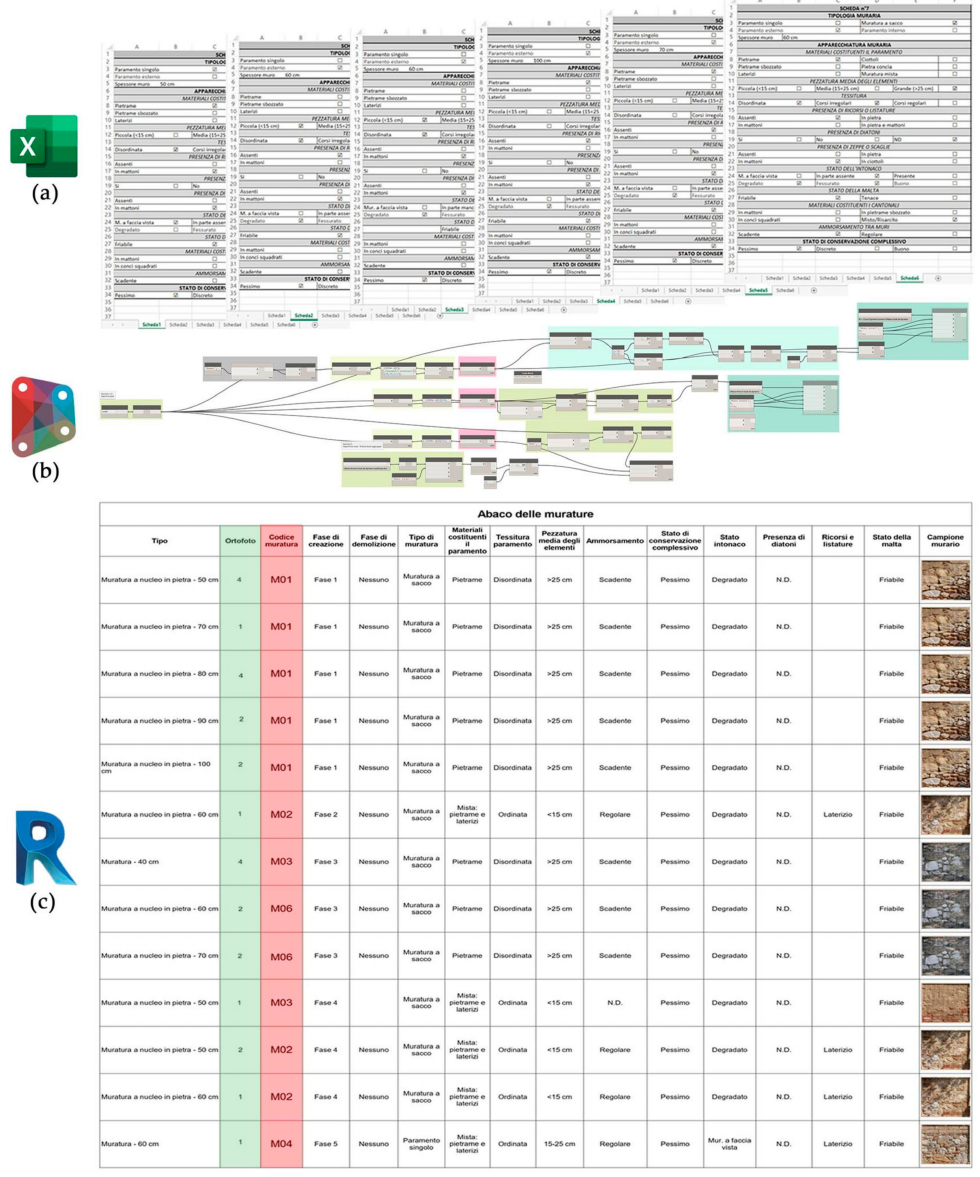
Figure 7. The records relating to the wall samples, suitably cataloged within alphanumeric spread- sheets ( a ), are linked to the continuous three-dimensional model through visual programming ( b ). Within the modeler, it is possible to use the same information in table form ( c ) while maintaining the ease of modification of the original platform. The codes (red) assigned to the wall elements are visible in the relative images (green) (see Figure